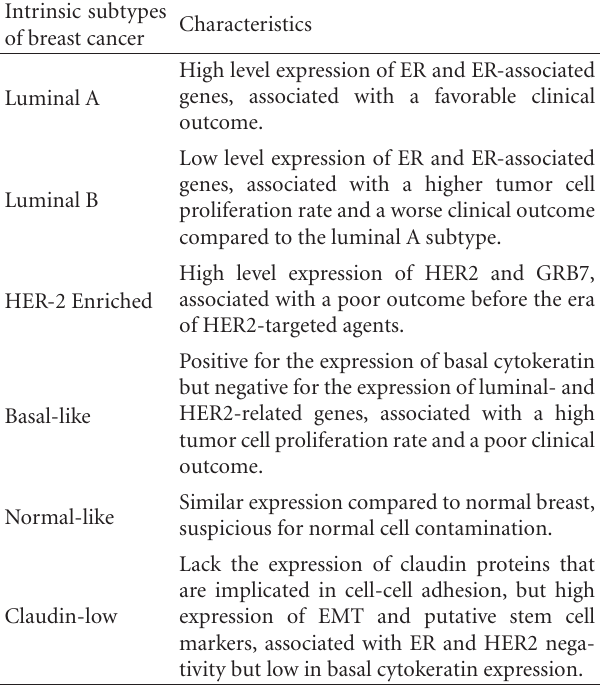
Table 1: Intrinsic subtypes of breast